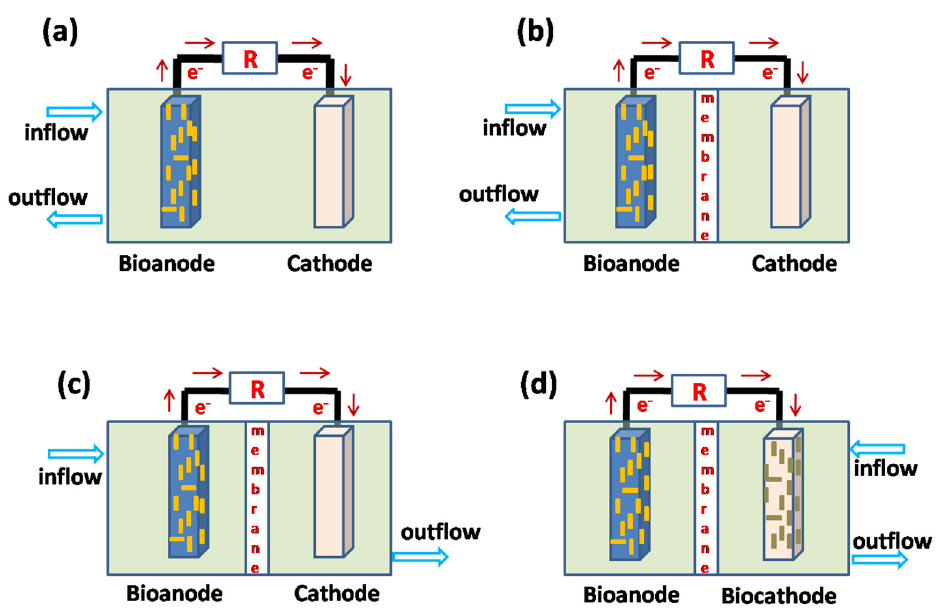
Figure 9. Different processes for antibiotics removal in MFCs: ( a ) single-chamber MFC, ( b ) dual- chamber MFC, ( c ) sequential anode-cathode operation in a dual-chamber MFC, and ( d ) biocathode operation in a dual-chamber MFC according to Zakaria and Dhar [143].